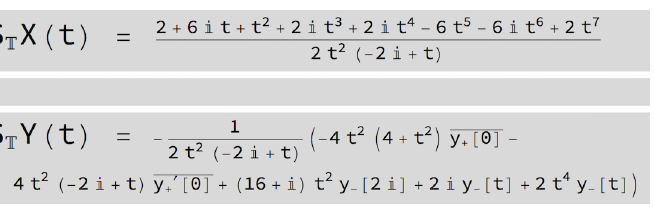
Figure 6. Output given by the [SInt] algorithm.